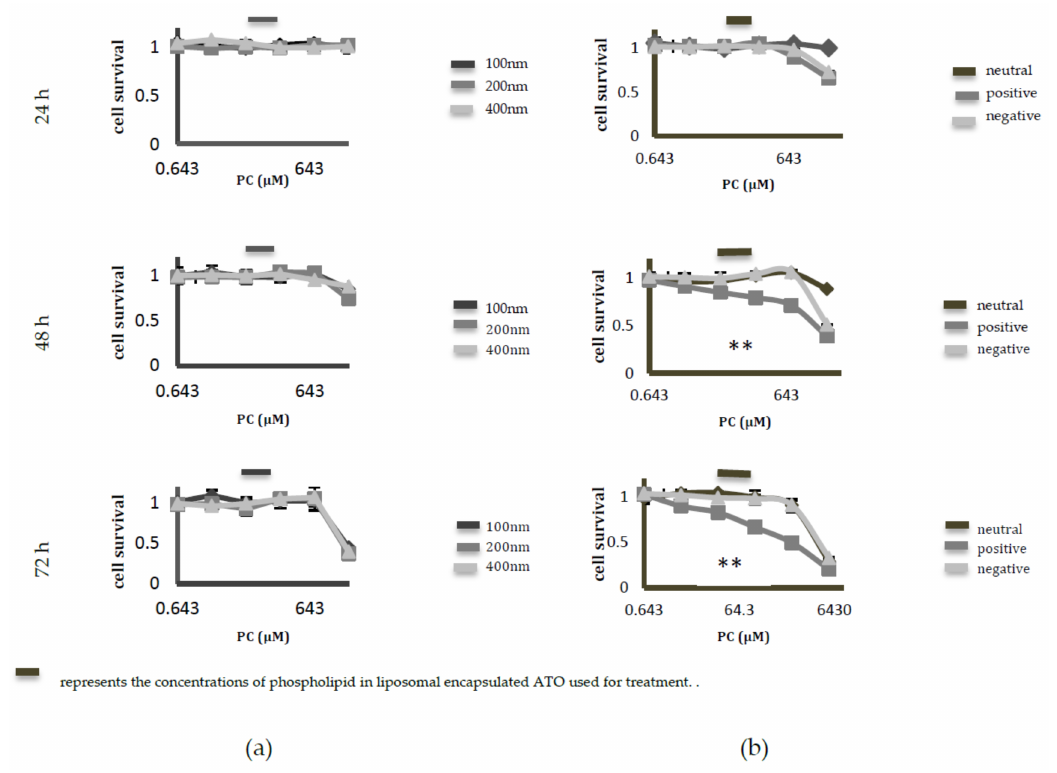
Figure 3. The MTT assay used to test the cytotoxicity of various control liposomal formulations on cervical cancer cells. The cellular toxicity that is induced by control (empty) liposomes of different ( a ) sizes and ( b ) charges is represented following an incubation period of 24, 48 and 72 h with HeLa cells. The positively-charged liposomes displayed noticeable toxicity at 48 h exposure and at the same dilution factor that was used for diluting liposomal encapsulated ATO. Neutral liposomes were found to show the least toxicity. Data are presented as mean ± SD of three replicate experiments; ** p < 0.01. PC: